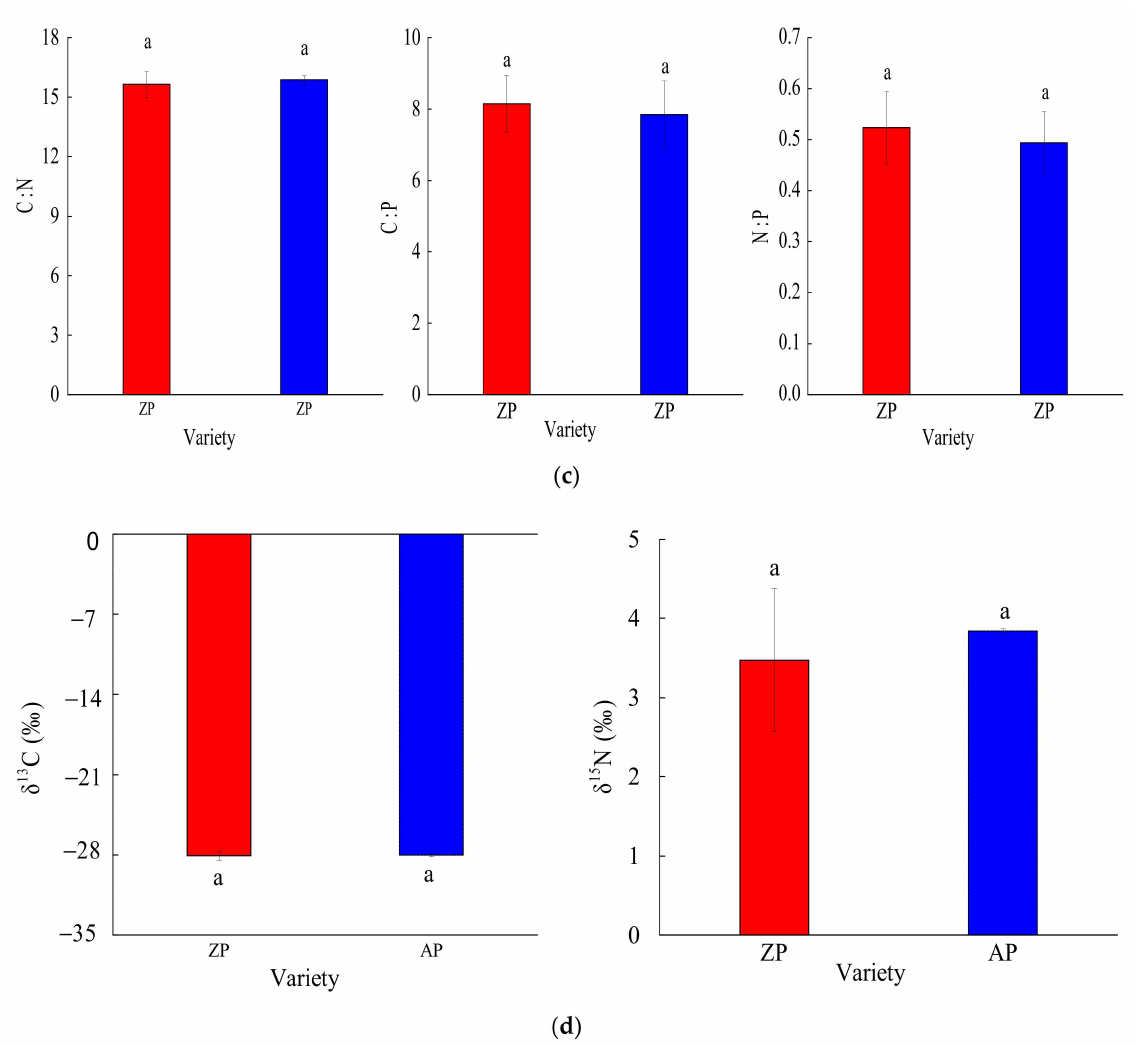
Figure 2. Root functional traits of Zanthoxylum planispinum ‘dintanensis’ and Zanthoxylum armatum ‘novemfolius’. Different letters represent significant differences at the level of p < 0.05. ( a ) The comparison of the root structural traits between Zanthoxylum planispinum ‘dintanensis’ and Zanthoxy- lum armatum ‘novemfolius’. ( b ) The comparison of the root element traits between Zanthoxylum planispinum ‘dintanensis’ and Zanthoxylum armatum ‘novemfolius’. ( c ) The comparison of the root element stoichiometry between Zanthoxylum planispinum ‘dintanensis’ and Zanthoxylum armatum ‘novemfolius’. ( d ) The comparison of the root physiological traits between Zanthoxylum planispinum ‘dintanensis’ and Zanthoxylum armatum